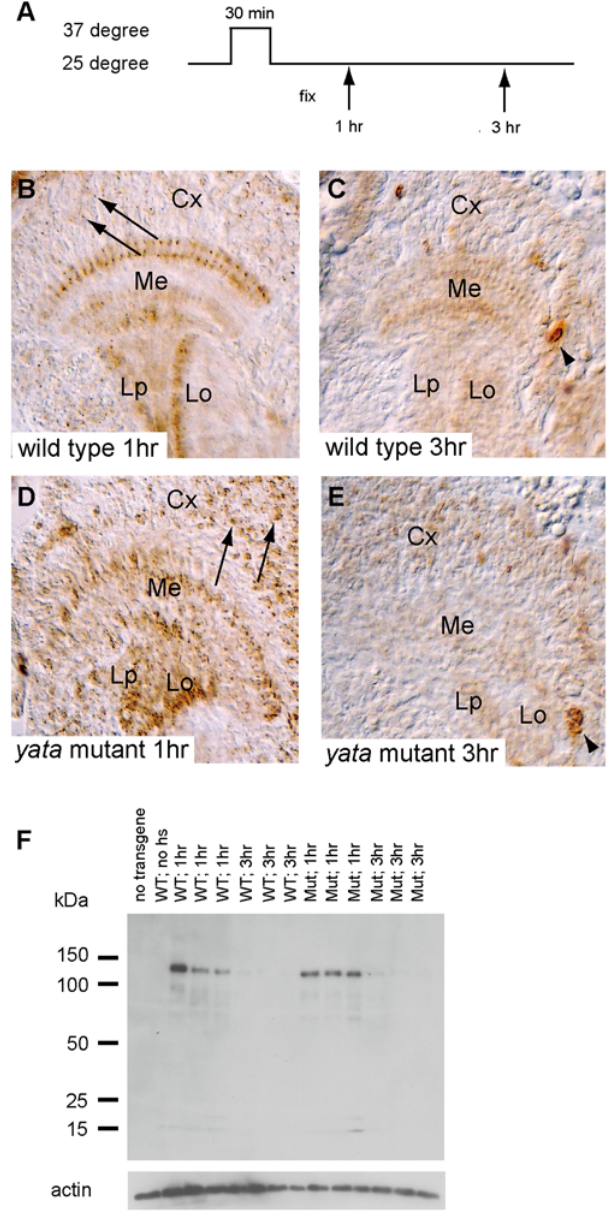
Figure 5. Impaired subcellular localization of exogenously expressed APPL-FLAG in the yata mutant brain. (A) Profile for induction using heat shock promoter. (B, C) Localization of APPL-FLAG in mid pupa, fixed at 1 hour (B) and 3 hours (C). (D, E) Localization of APPL-FLAG in the yata mutant in mid pupa at 1 hour (D) and 3 hours (E). Punctate signals were observed in cell bodies at 1 hour (arrows in B and D). In yata mutants, preferential localization of APPL-FLAG was observed in cell bodies (D, E). A few unidentified cells showed exceptionally strong staining at 3 hours (arrowheads in C and E). Cx: cortical regions, Me: medulla, Lo: lobula, Lp: lobula plate. (F) Western analysis for heat-shock induction of APPL-FLAG using antibody for the C-terminal FLAG tag and anti-actin antibody. Protein lysates of 1/20 portions of single mid pupae were loaded for each lane. At 1 hour after heat shock, the full-length product of APPL-FLAG was induced. This amount decreased at 3 hours in both wild-type and yata mutant pupae.